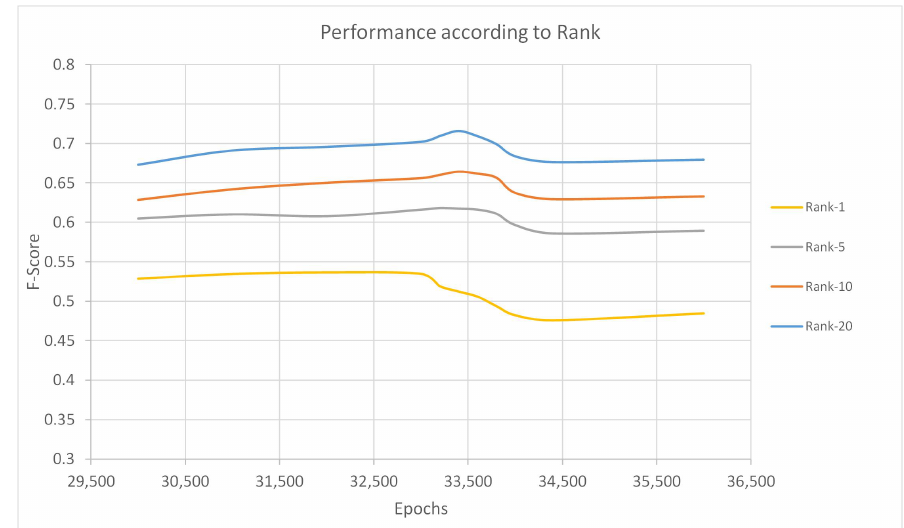
Figure 10. Performance of our proposed method according to Rank.